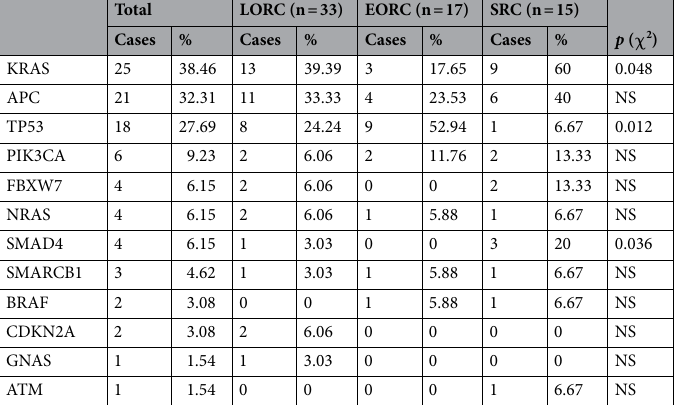
Table 2. Spectrum of cancer gene mutations among rectal cancer patients by age of disease-onset group and synchronous rectal cancer cases using next generation sequencing. EORC, early-onset rectal cancer; LORC, late-onset rectal cancer; NS, not significant; SRC, synchronous rectal cancer.